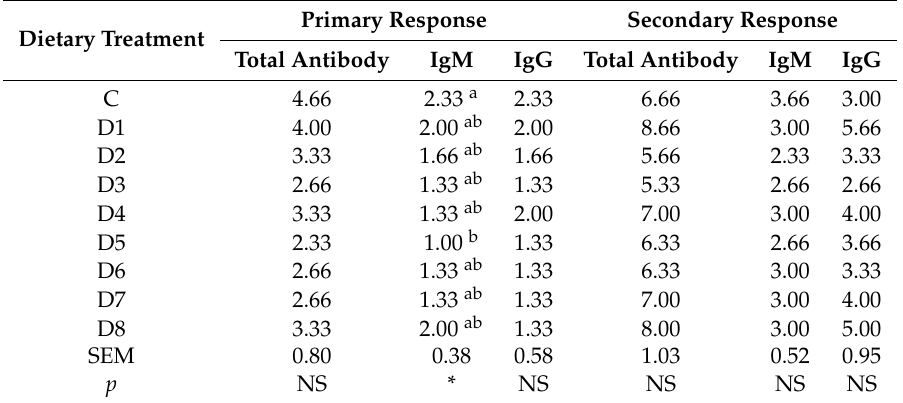
Table 6. Anti- Sheep Red Blood Cells (SRBC) antibody responses (log 10 ) of broilers fed di ff erent levels of L-carnitine and